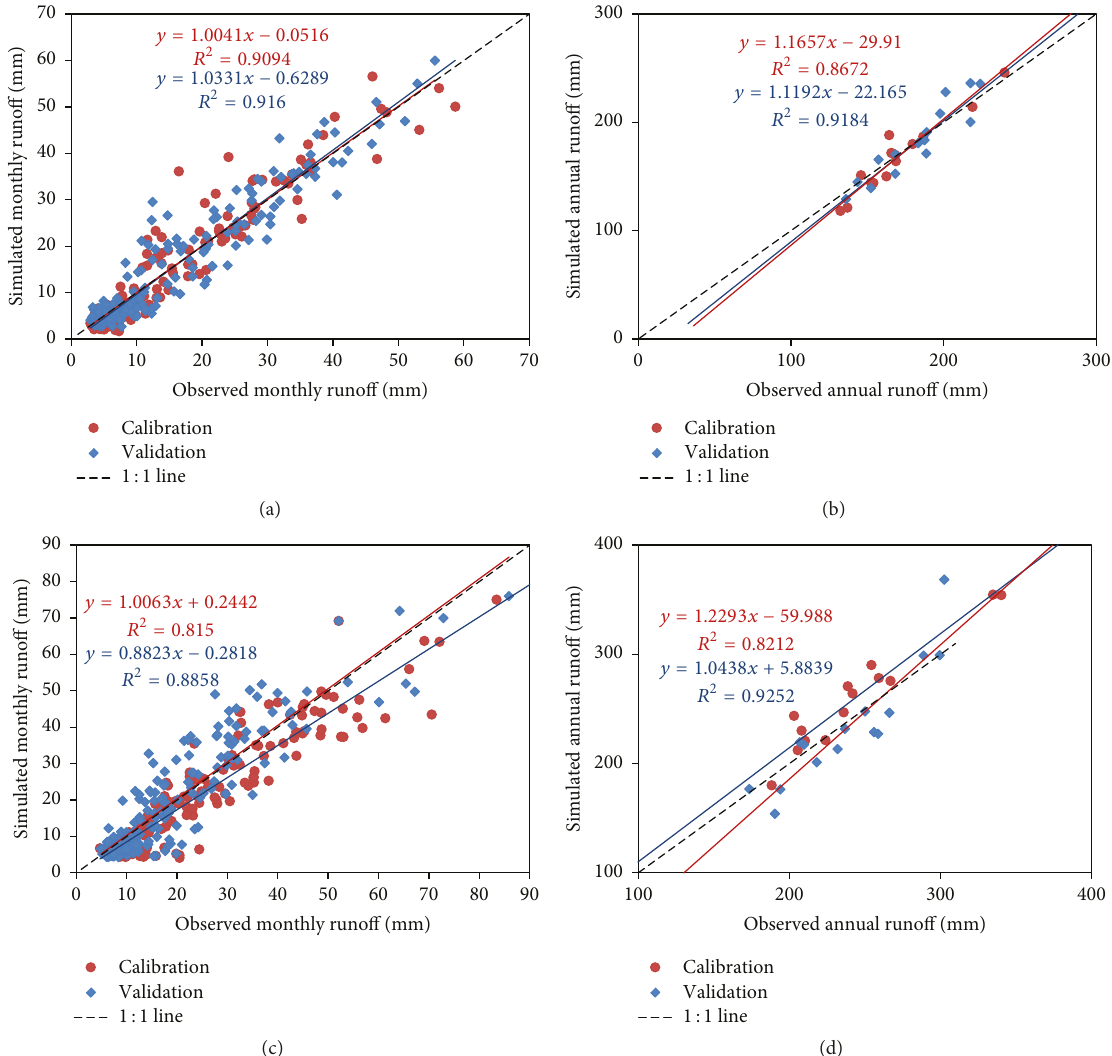
Figure 4: Scatter plots of observed and simulated runoff in YLC at (a) monthly and (b) annual scales and in MXC at (c) monthly and (d) annual